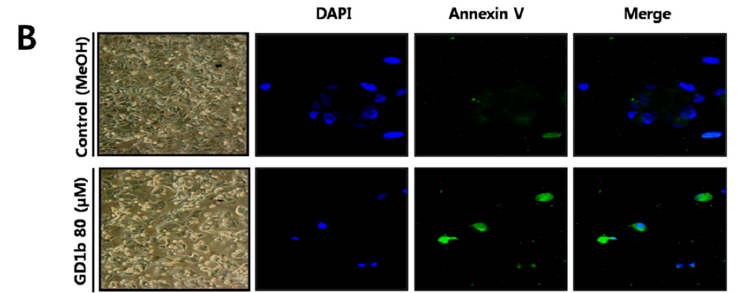
Figure 3. Apoptosis of MCF-7 cells by GD1b treatment. ( A ) Double staining of the MCF-7 cells treated GD1b using annexin V and PI. Control (left) was treated with 80 µL/mL of methanol and right phannal was treated with 80 µM of GD1b for 24 h and stained with FITC-conjugated Annexin V ( top ) and PI ( bottom ) and then analyzed by flow cytometry; ( B ) Effect of GD1b on MCF-7 cells morphological changes (left). Morphological changes of control cells and cells treated GD1b were observed under a phase-contrast microscope with 100×. Apoptosis of MCF-7 cells treated with GD1b was stained with DAPI and Annexin V. Control (upon) was treated with 80 µL/mL of methanol. Cells sown in the lower pannel was treated with 80 µM of GD1b for 24 h and stained with FITC-conjugated Annexin V and DAPI and then analyzed by immunocytostaining (magnification 63×).